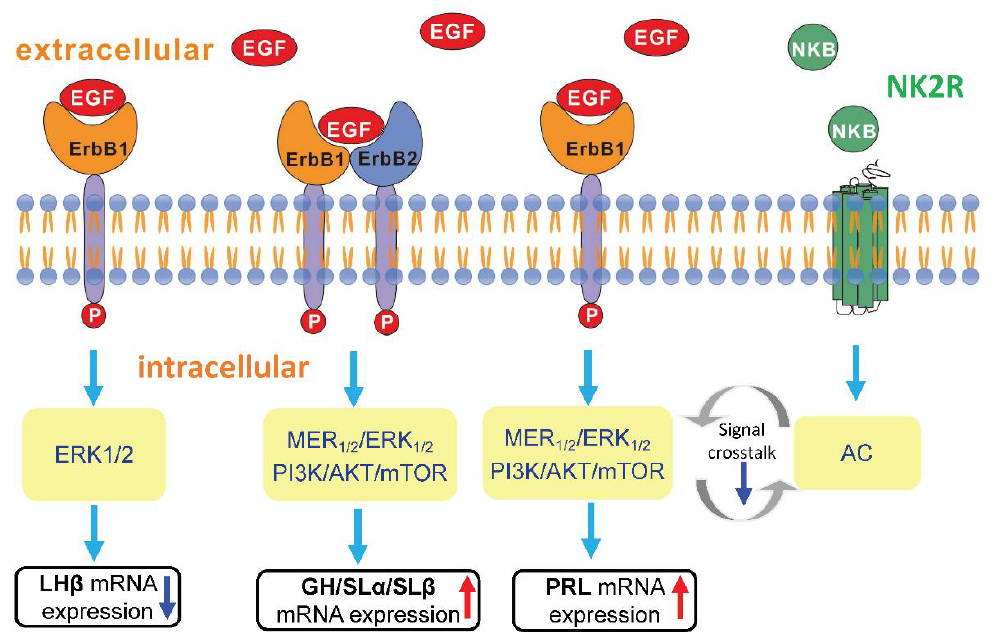
Table S1: The information for the drugs used in receptor specificity and signal transduction. Table S2: Primers used for quantitative real-time PCR in this study. Table S3: Antibodies used in fluorescence immunoassay. Table S4: The e ff ects of EGF on pituitary hormones at 24 h by transcriptome analysis. Fragments per kilobase of exon per million fragments mapped (FPKM), Fold Change (FC). Figure S1: EGF-induced protein phosphorylation